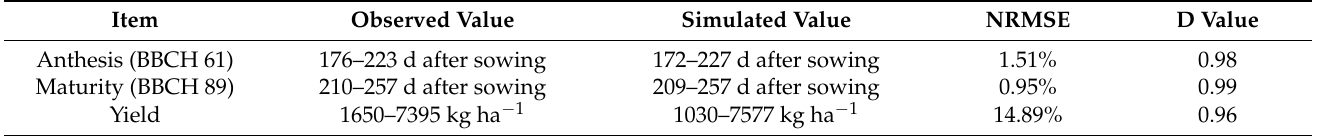
Table 3. Validation of simulation on anthesis, maturity, and yield of winter wheat in the North China